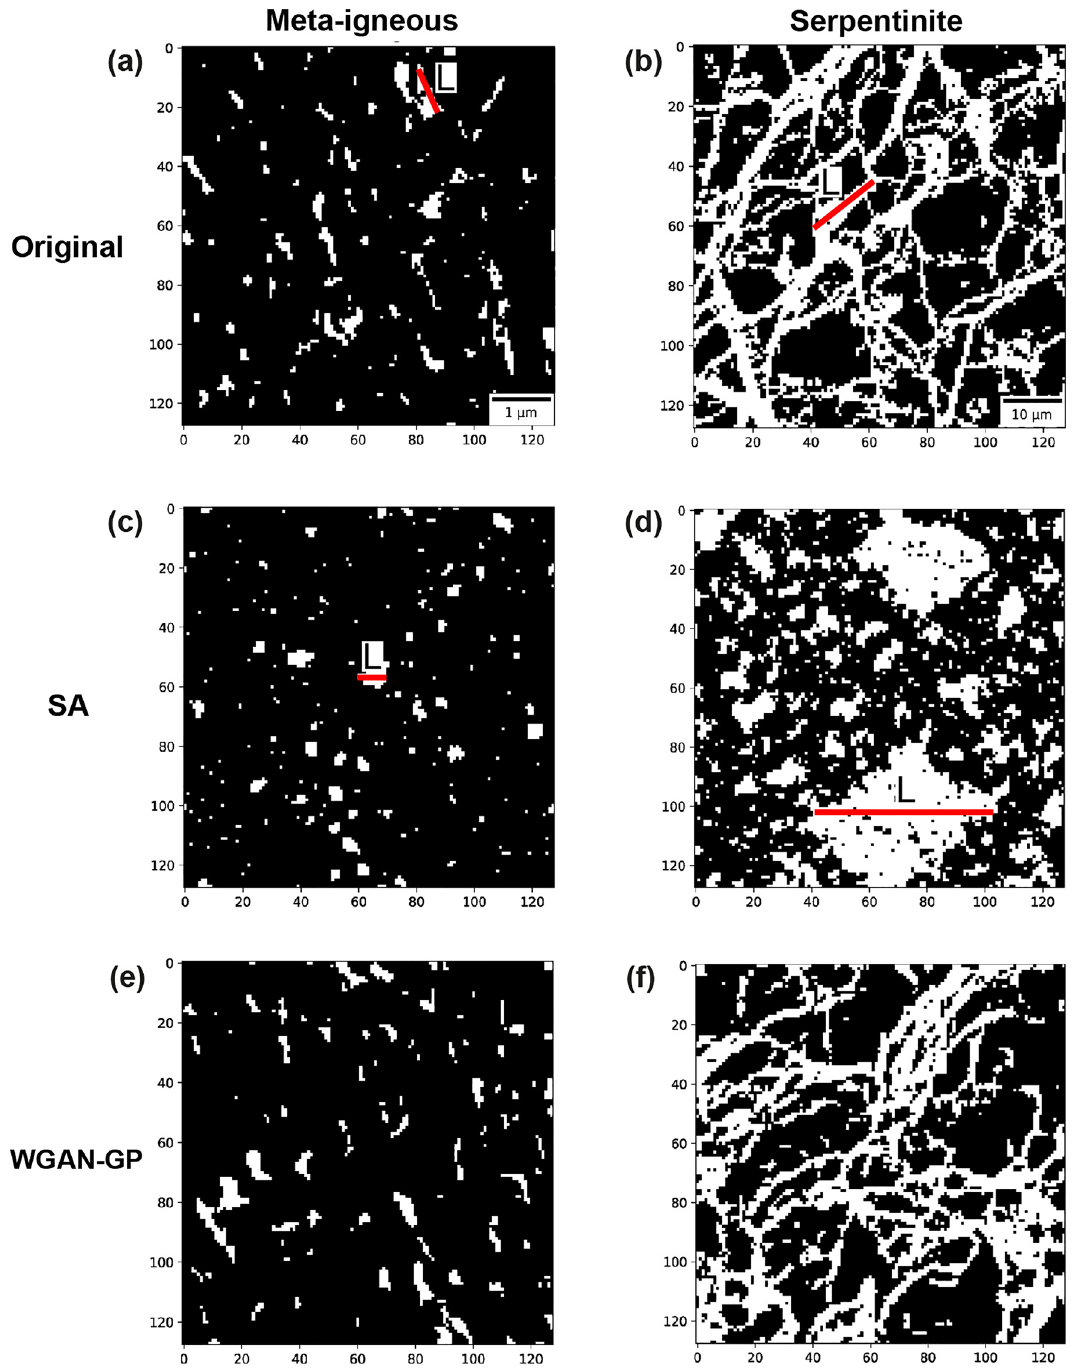
Figure 3. Visual comparison of real ( a , b ) with reconstructed images using SA ( c , d ) and WGAN-GP ( e , f ). Red solid lines illustrate how the lineal-path function L can describe the linear clusters and connectivity in the